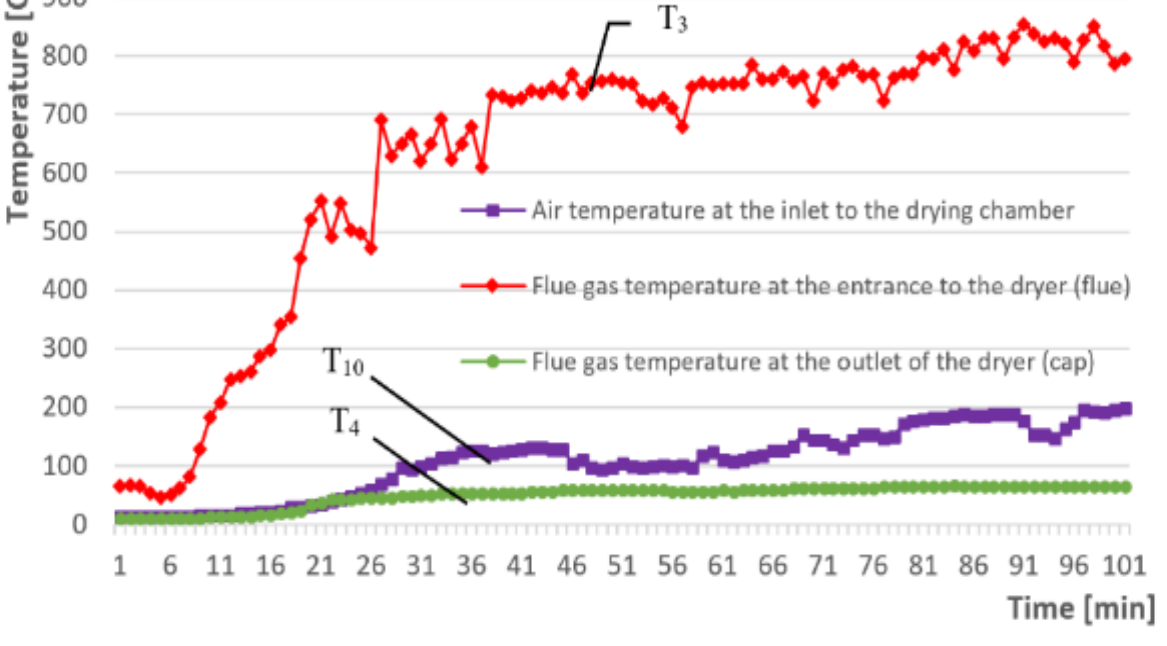
Figure 4. Temperature increase vs. time at 3 measuring points of the dryer: T 3 , T 4 and T 10 .